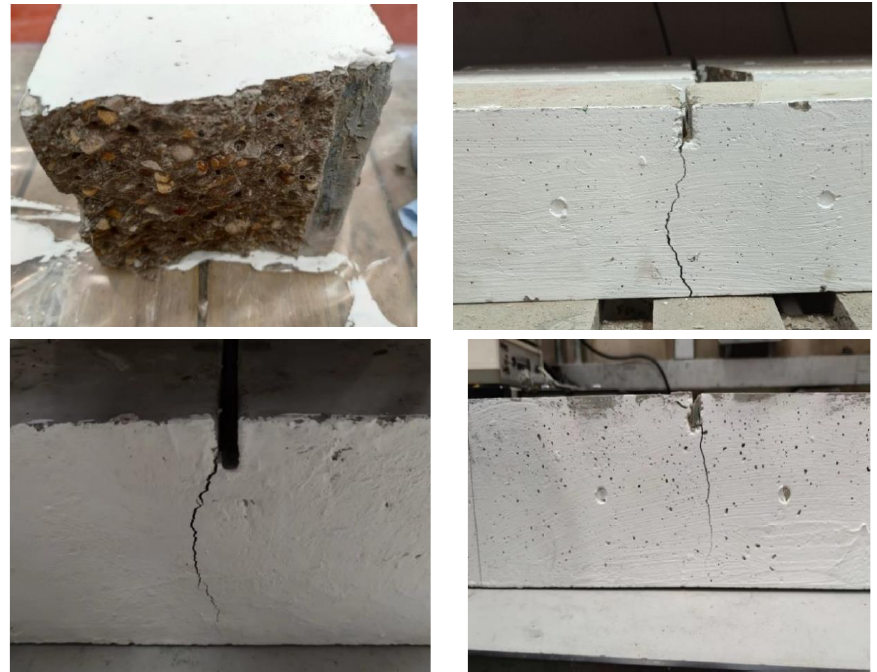
Figure 7. The post-crack of the concrete specimen after the bending test by contrast (left upper is M0, right upper is M1, left bottom is M2 and right bottom is